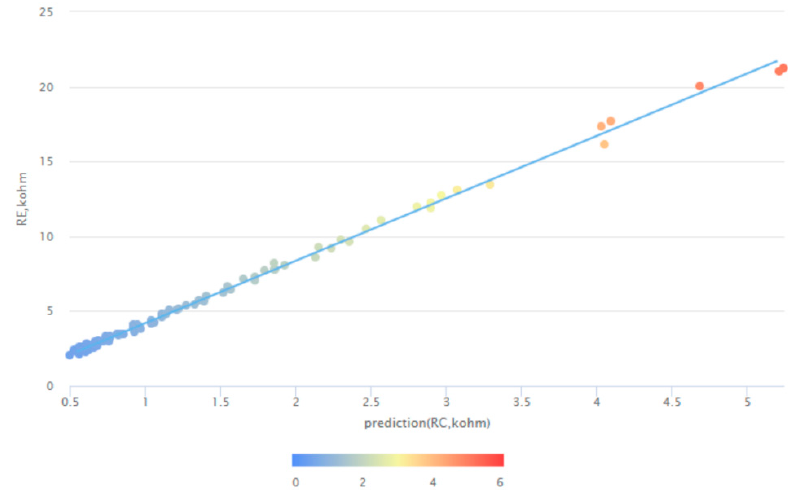
Figure 12. Predicted dependence between R C and R E .